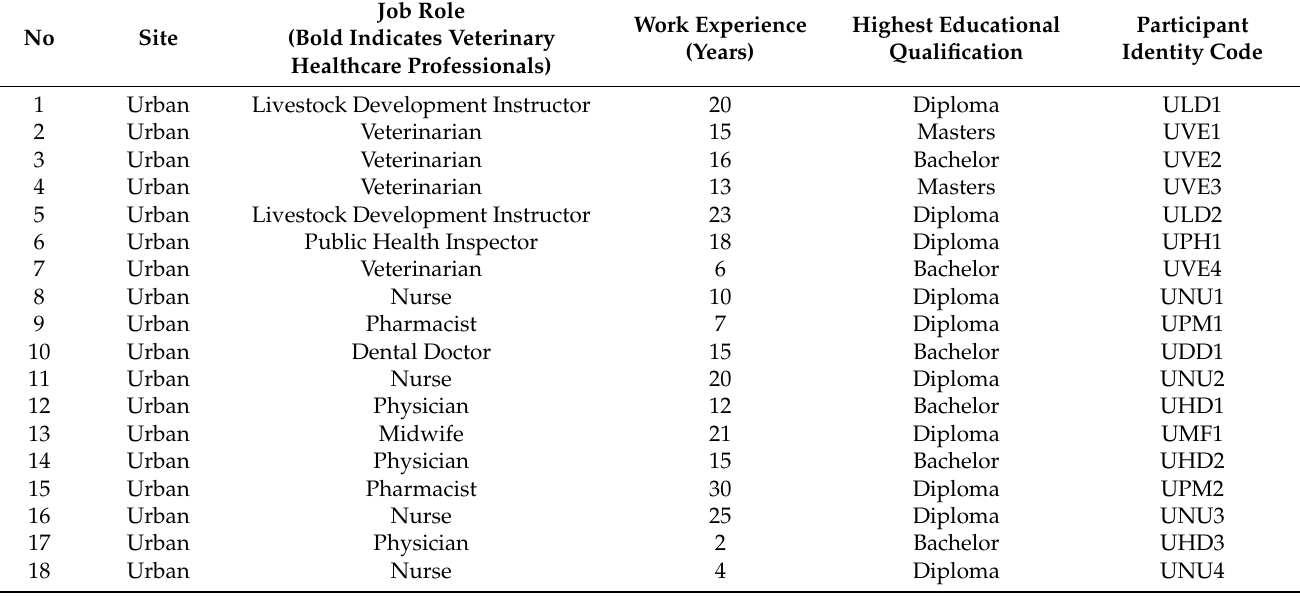
Table 1. Demographic Characteristics of